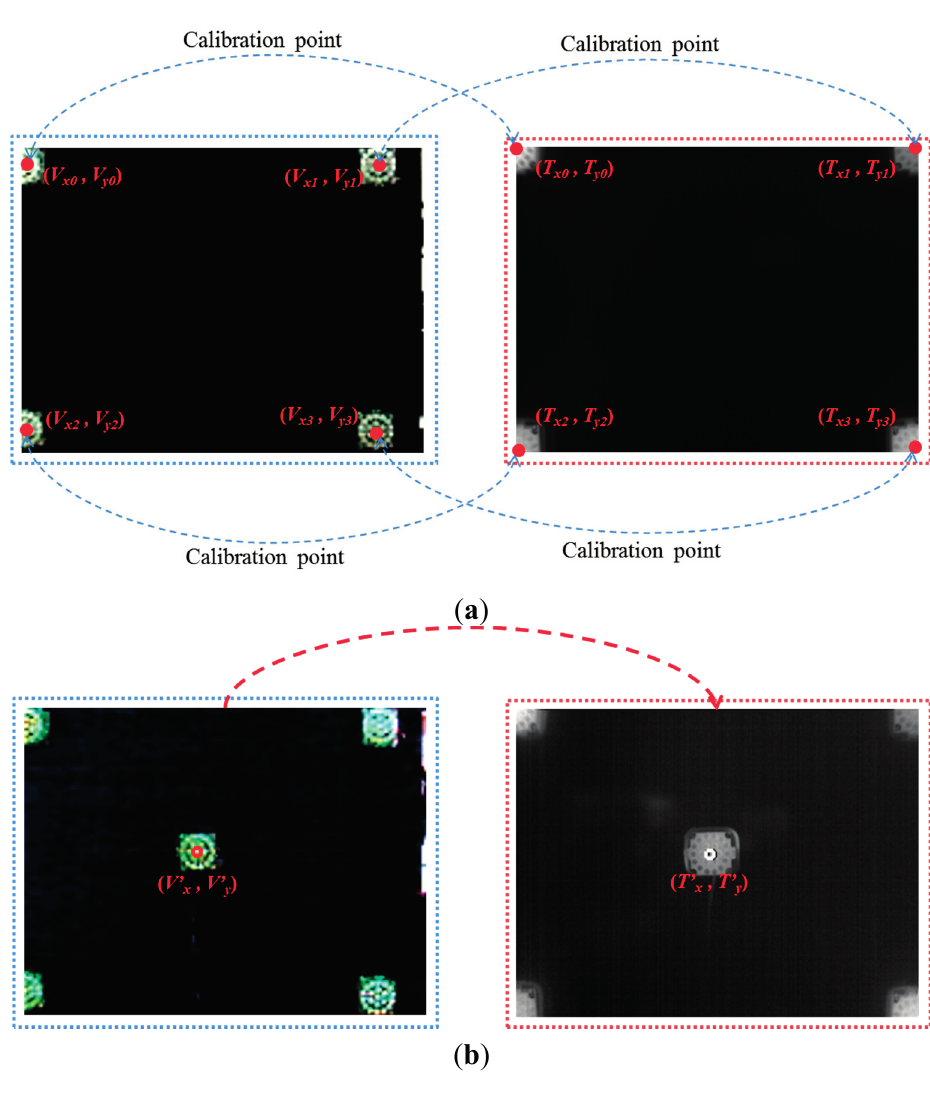
Figure 5. Four corresponding (calibration) pairs of points produced by four NIR illuminators to obtain the geometric transform matrix and an example for measuring calibration accuracy. ( a ) Four pairs of corresponding (calibration) points; ( b ) pair of points for measuring calibration accuracy.